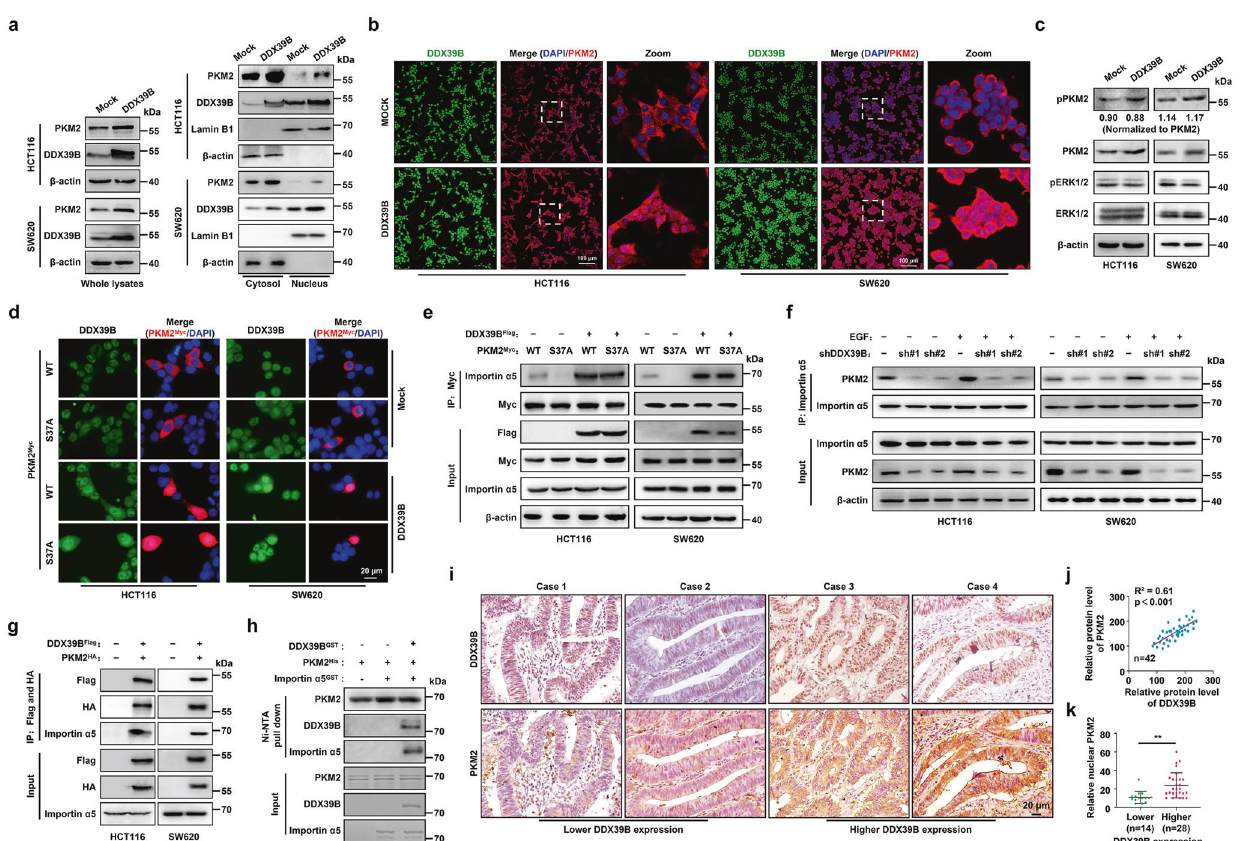
Fig. 5 DDX39B promotes ERK-independent PKM2 nuclear translocation. a Nuclear and cytosolic protein lysates prepared from HCT116 and SW620 cells stably expressing mock or DDX39B were assayed by western blotting. b The subcellular localization of PKM2 in HCT116 and SW620 cells stably expressing mock or DDX39B was visualized by immuno fl uorescence assay. c Phosphorylation of PKM2 S37 and ERK1 T202/Y204 , ERK2 T185/Y187 in CRC cells stably expressing mock or DDX39B was detected by western blotting. d The indicated CRC cells were cotransfected with Flag-DDX39B and Myc-PKM2 WT or Myc-PKM2 S37A , and immuno fl uorescence assay was performed. e The CRC cells were cotransfected as indicated, and the binding of importin α 5 to PKM2 WT or PKM2 S37A was evaluated by immunoprecipitation assay. f DDX39B-knockdown CRC cells were treated with or without 150 ng/ml EGF, and the association of importin α 5 with PKM2 was detected by immunoprecipitation assay. g Lysates prepared from CRC cells cotransfected with Flag-DDX39B and HA-PKM2 were subjected to tandem af fi nity puri fi cation using anti- Flag and anti-HA magnetic beads. h In vitro binding analysis was performed using the indicated puri fi ed proteins. i DDX39B and PKM2 protein levels in serial sections of CRC tissues ( n = 42) were measured by immunohistochemistry staining. j The correlation of relative staining intensities between DDX39B and PKM2. k The association of DDX39B and nuclear PKM2 in CRC tissues. The p values were determined by Pearson correlation coef fi cient analysis ( j ) or Student ’ s t test ( k ). ** p <